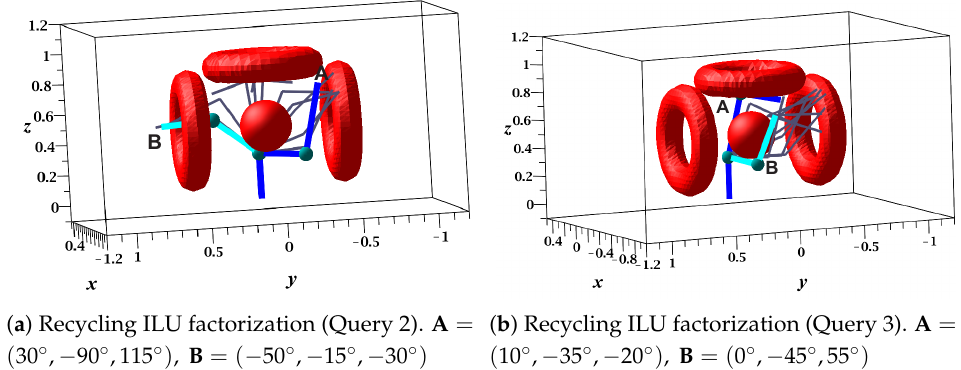
Figure 12. Recycled collision-free paths of the 3 DOF manipulator.